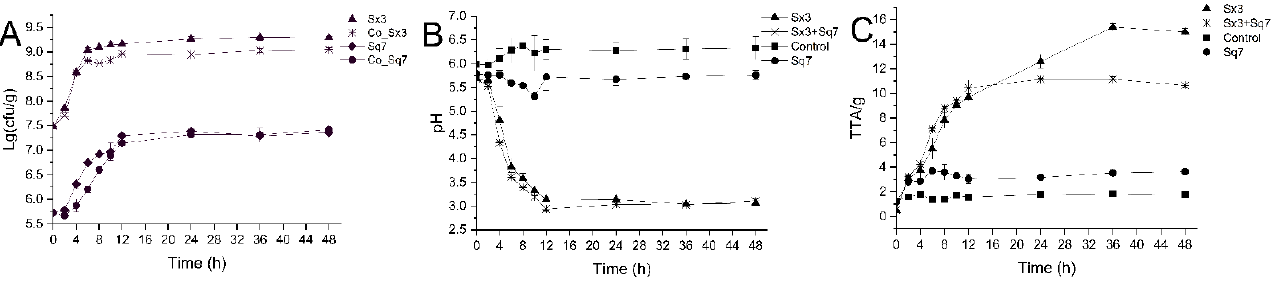
Figure 1. Cell counts of Sx3 and Sq7 in single culture and cocultivation ( A ), pH of sourdough ( B ), TTA of sourdough ( C ).